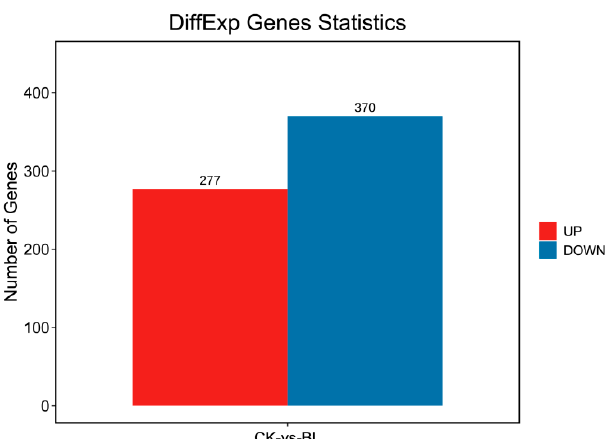
Figure 6. Differential gene statistical map. Red represents upregulated DEGs, blue represents downregulated DEGs.